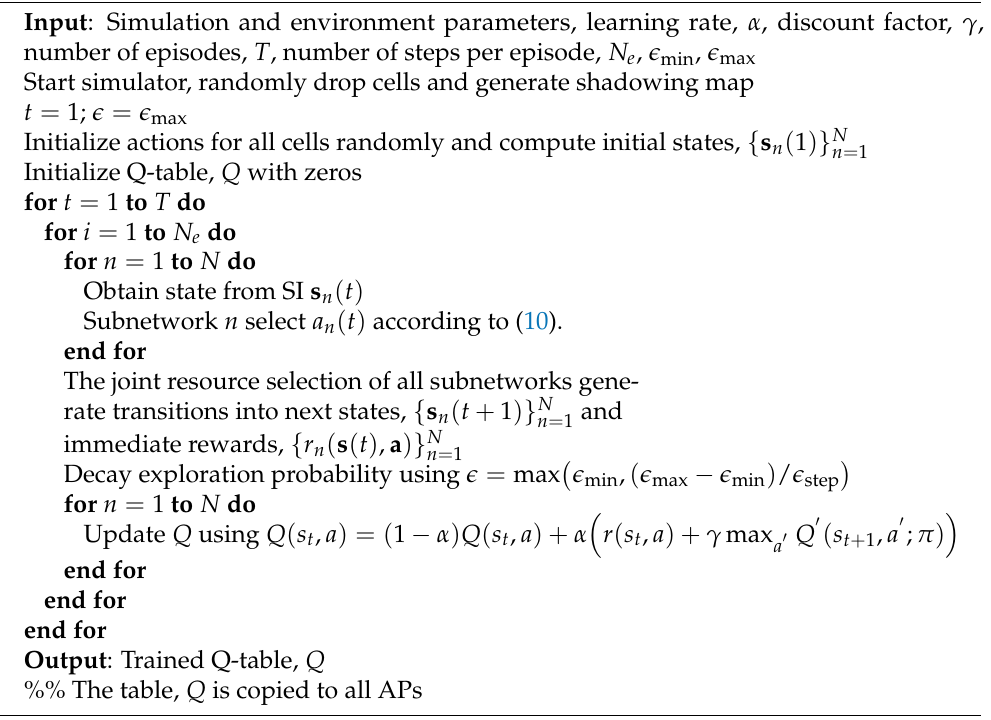
Algorithm 1 Multi-Agent Resource Allocation with Quantized SI: Training